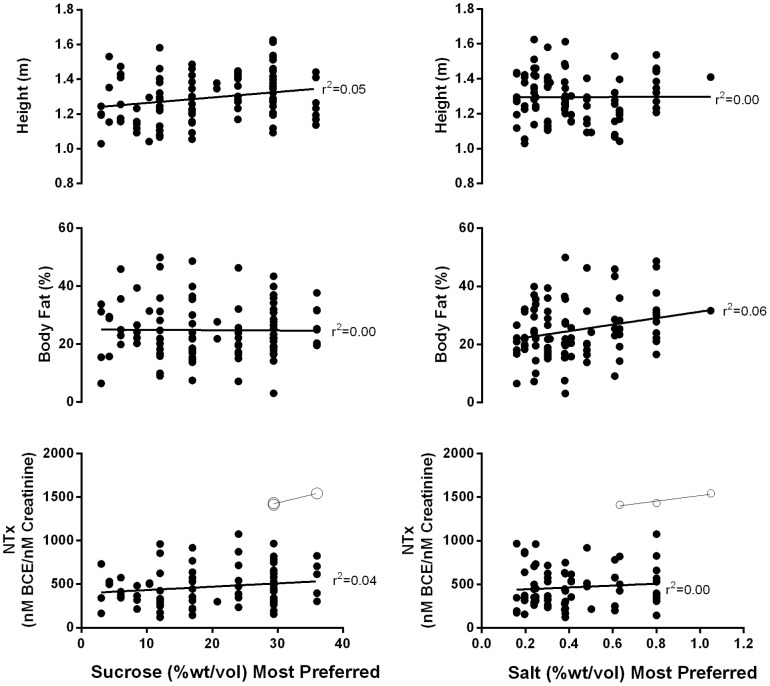
Associations between sweet and salty taste preferences and height, percent body fat, and NTx.Panels show associations between most preferred levels of sweet (left) and salty (right) tastes and height (top), percent body fat (middle), and NTx (bottom). Three outlying values of NTx (open data points) were removed for most analyses but are shown here for comparison.